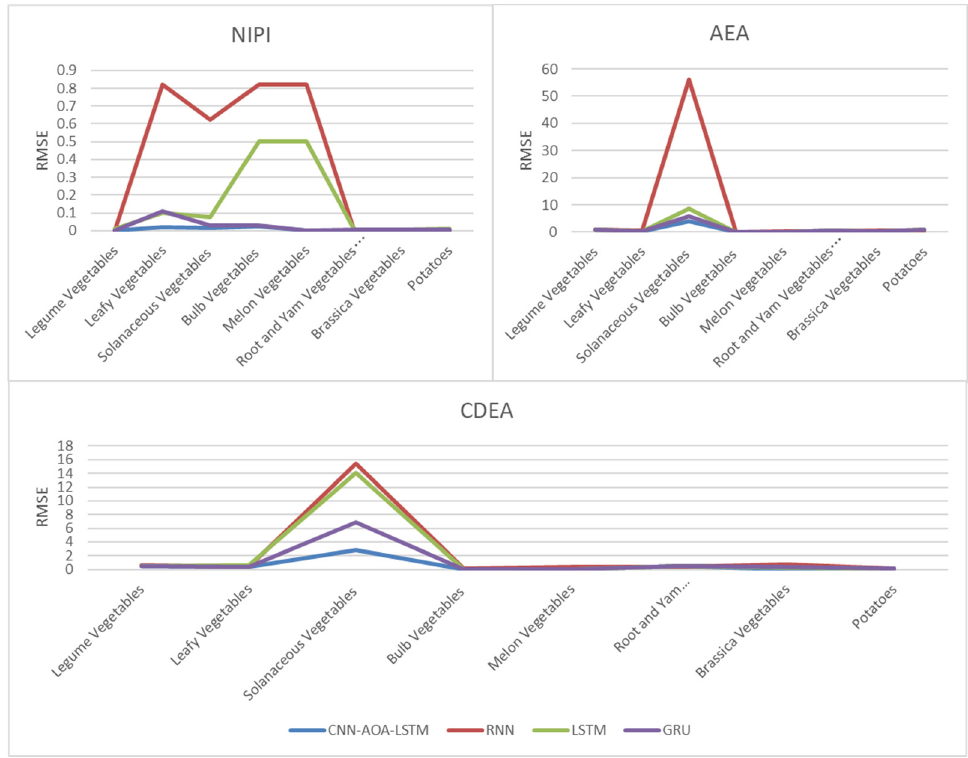
Figure 16. RMSE of NIPI, AEA and CDEA indexes.